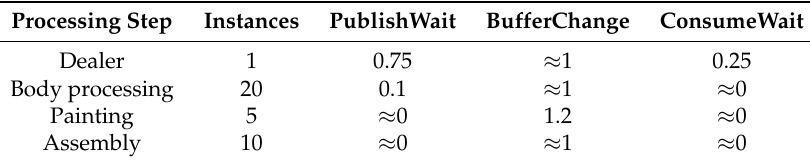
Table 3. Scenario